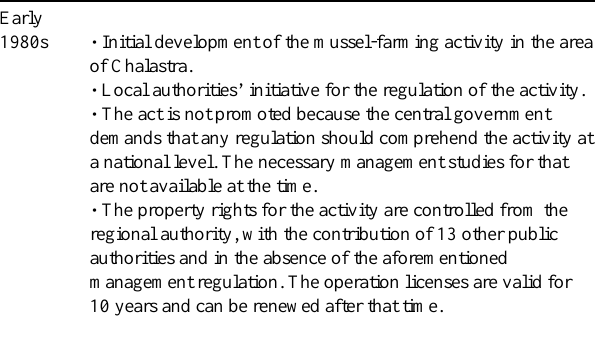
Table 1 . Institutional event